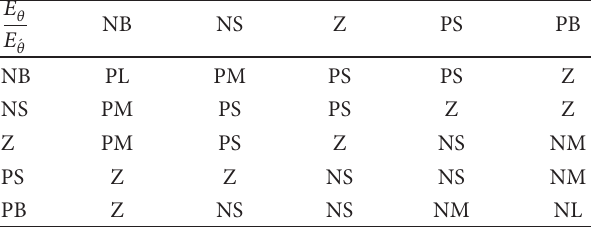
Table 2: Fuzzy rules for first fuzzy